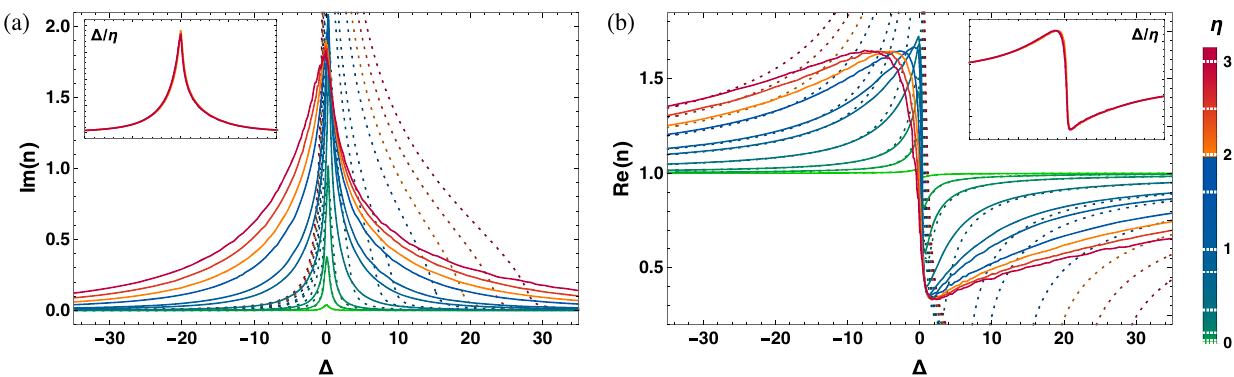
FIG. 3. Frequency-dependent refractive index for different atomic densities. The solid lines portray the imaginary (a) and real (b) parts of the refractive index versus dimensionless detuning Δ , obtained through Eq. (6), while the dotted lines show the MB predictions. The colors denote different atomic densities (color bar on the right), with the specific values indicated by the dotted white lines. The refractive index is inferred by averaging the complex transmission coefficient t ð Δ Þ over about 10 3 – 10 4 atomic configurations. Other = λ 0 ≤ 7 , and beam waist 2 . 5 ≤ w 0 = λ 0 ≤ 3 . The insets system parameters are as follows: thickness d ¼ 0 . 4 λ 0 , transverse radius 5 ≤ l cyl show the curves at the three highest densities as a function of the rescaled detuning Δ = η